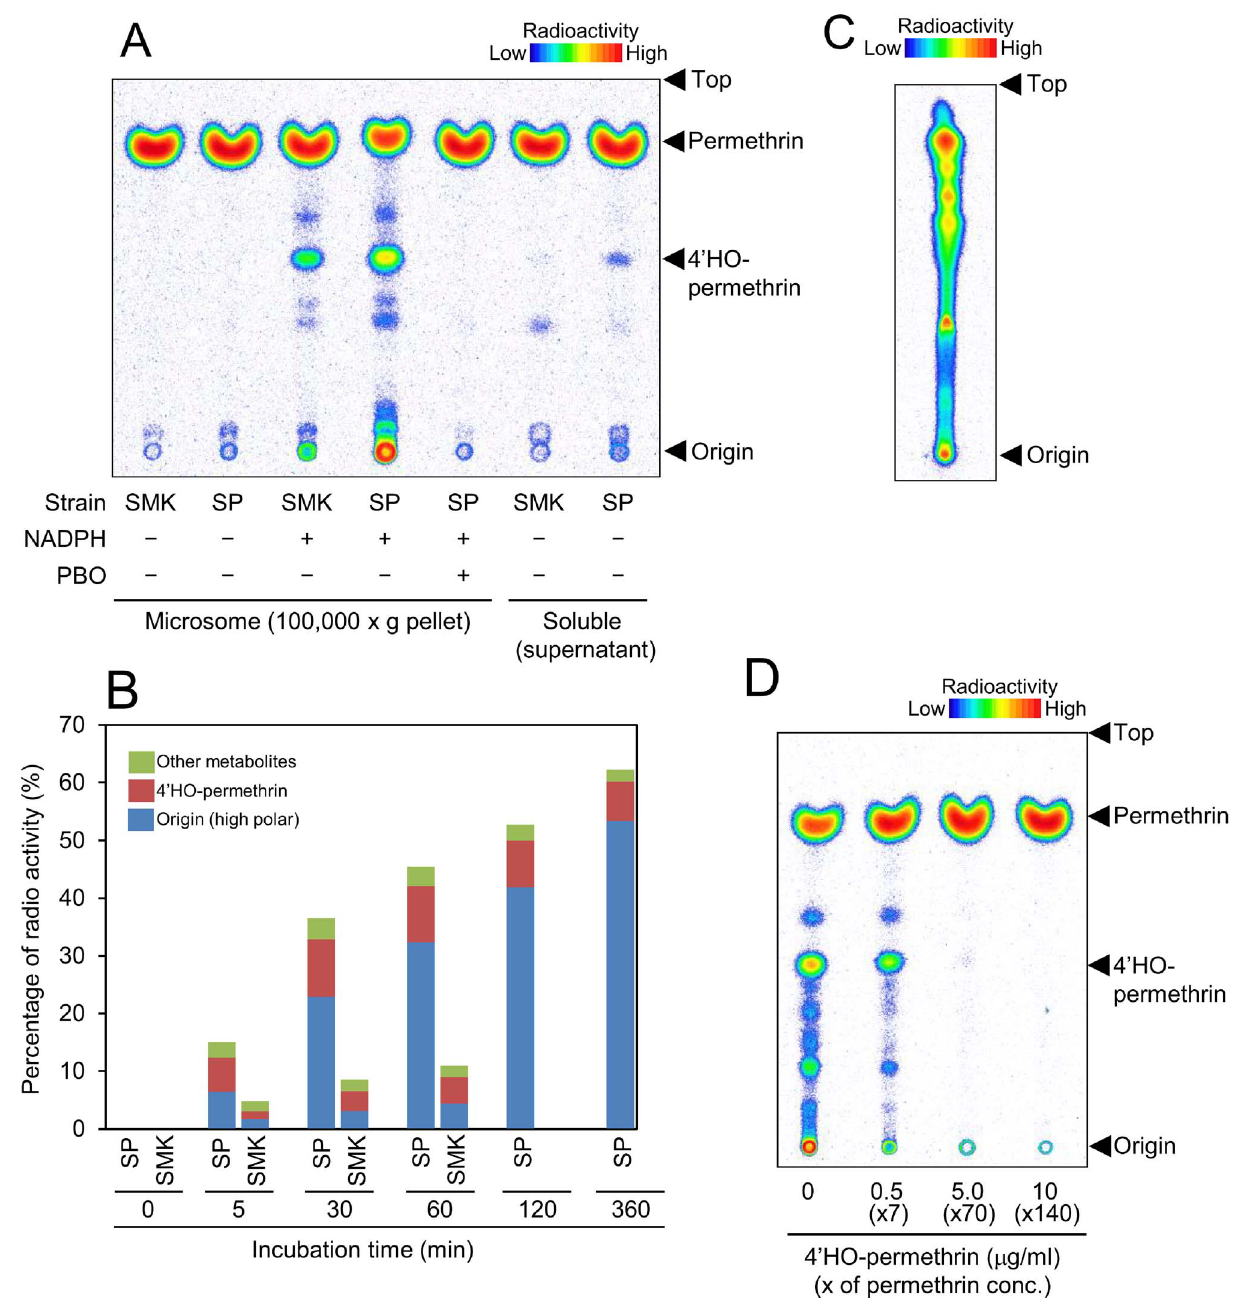
Figure 3. Invitro [ 14 C]-permethrin metabolism studies. (A) Thin-layer chromatogram of in vitro permethrin metabolism in adult Aedes aegypti with or without NADPH or PBO. Microsomes (100,000 6 g pellet) and the soluble fraction (100,000 6 g supernatant) were used as the enzyme source. The presence of 4 9 -HO-permethrin was determined by co-chromatography with an authenticated chemical. (B) Metabolites of permethrin in adult A. aegypti at various incubation times. For detailed data, see Table S2. (C) Thin-layer chromatogram of high-polar compounds (SP) located at the origin of the first HPTLC. Developing solvents: chloroform/methanol/water (65:25:4). (D) Inhibition of permethrin metabolism by 4 9 -HO-permethrin. Microsomes of the SP strain were incubated for 30 min with [ 14 C]-permethrin, NADPH, and 6 7-, 6 70-, or 6 140-fold higher doses of 4 9 -HO-permethrin than permethrin.